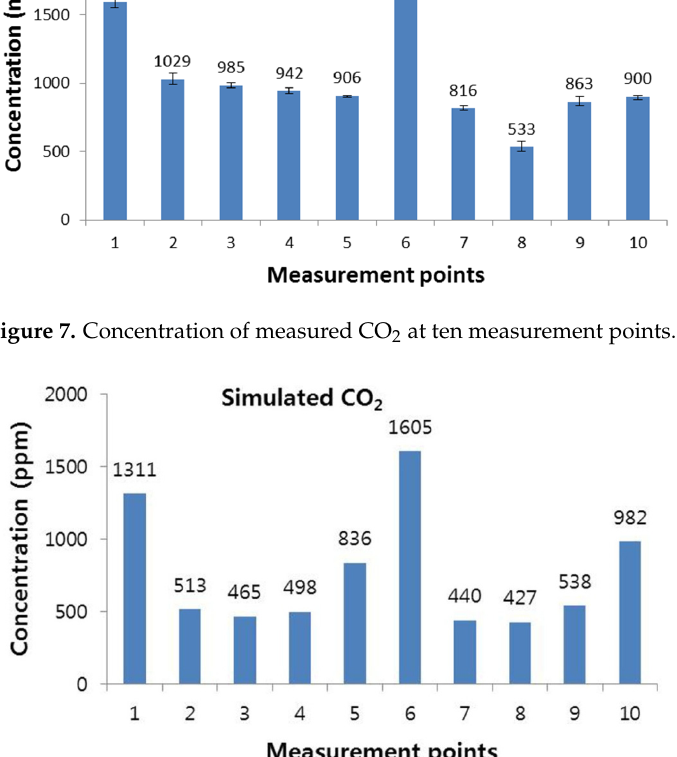
Figure 8. Concentration of simulated CO 2 at ten measurement points.